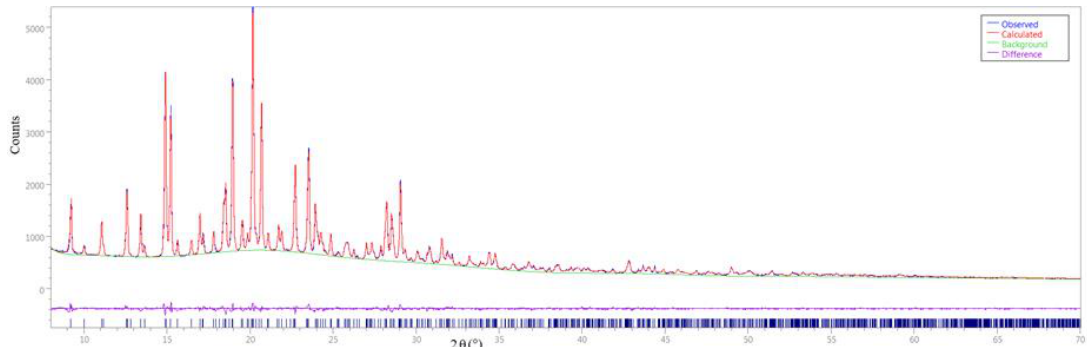
Figure 7. The result of the Rietveld refinement of MORPHOLIN by EXPO: observed profile (blue line), calculated profile (red line), background (green line) and difference profile (purple line) are shown.